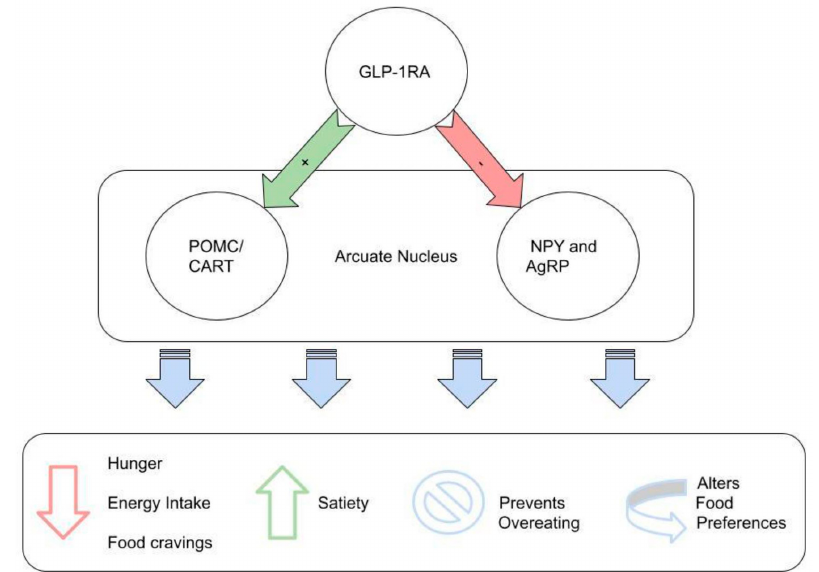
Figure 5. GLP-1RAs reduce feelings of hunger, energy intake, and food cravings. The drugs also increase satiety, prevent overeating, and alter food preference. GLP-1RAs actions are a result of GLP-1R activation on POMC and cocaine-and amphetamine-regulated transcript (POMC/CART) neurons along with indirect inhibition of orexigenic neurons express neuropeptide Y (NPY) and agouti-related peptide (AgRP). All these neurons are located in the arcuate nucleus, which is located in hypothalamus and plays a crucial role in the regulation of hunger and satiety.